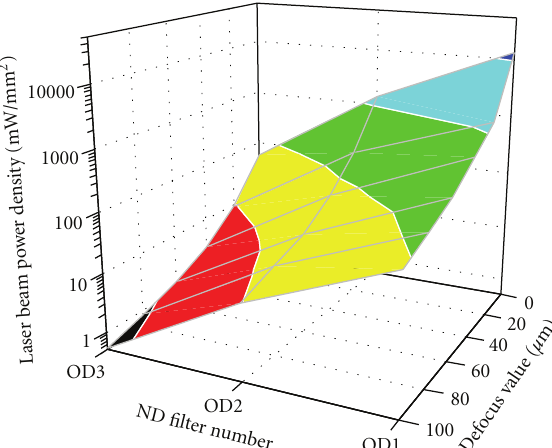
Figure 4: Power density of the Raman excitation laser beam measured as a function of ND filter number and the defocus value.